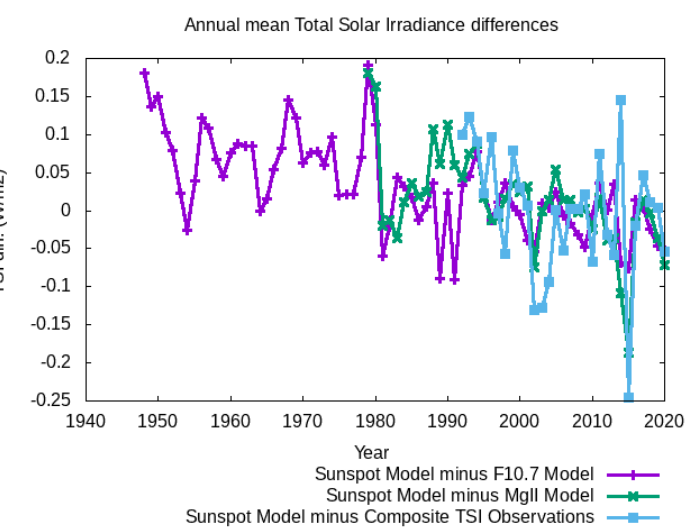
Figure 4. Difference between Sunspot-based annual mean TSI and other TSI estimates. Purple curve: difference with F10.7-based TSI Model. Green curve: difference with MgII-based TSI Model. Light blue curve: difference with Composite TSI